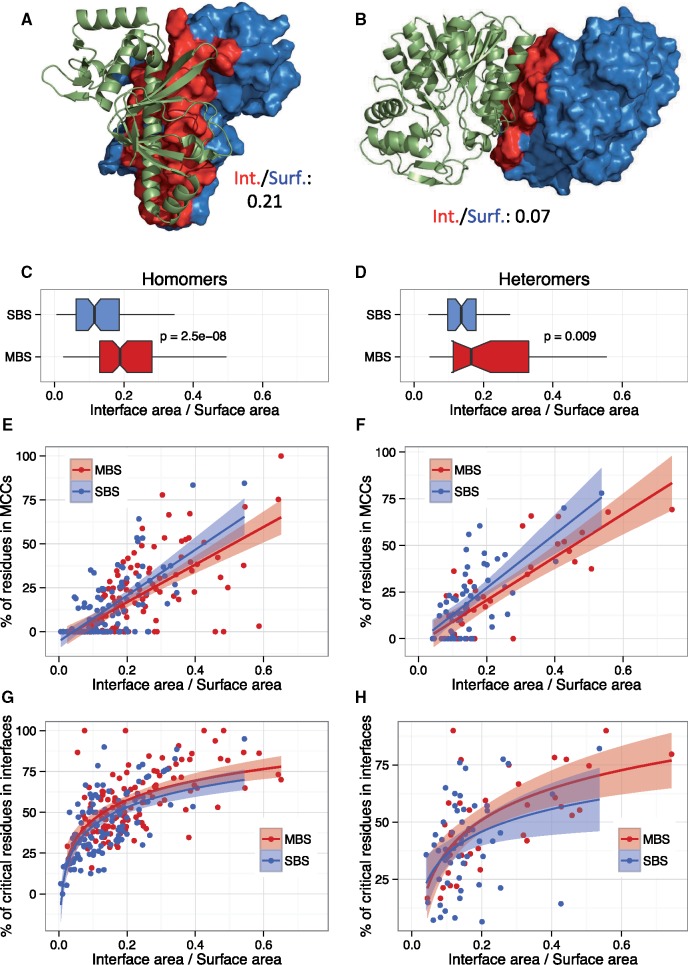
Community structure scales with the relative interface size of complexes. (A and B) Interface to surface ratios of NtcA and UDP-galactose 4 epimerase. Interface is highlighted with red, whereas the surface (shown only on one chain) with blue. (C and D) MBS complexes have significantly larger interface-to-surface ratios than SBS complexes, both in homomers and heteromers (Wilcoxon tests). (E–H) When interface-to-surface ratio is used as covariate, the percent of residues in MCCs (E and F), and the percent of critical residues in interfaces (G and H) scale similarly in allosteric MBS and SBS complexes (lines represent linear and logarithmic fit, with SE).